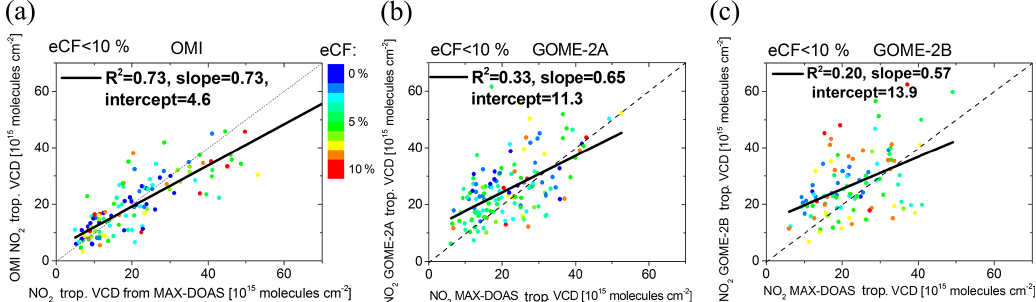
Figure 2. Daily-averaged NO 2 tropospheric VCDs derived from OMI (a) , GOME-2A (b) and GOME-2B (c) compared with the correspond- ing MAX-DOAS data for eCF<10%. The colours indicate the eCF.